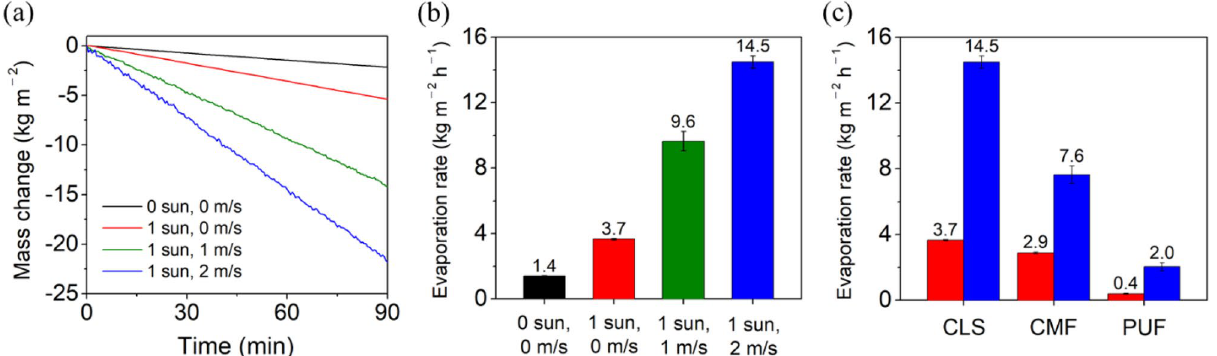
Figure 5. ( a ) Time-dependent changes in the mass of water under various conditions. ( b ) Evaporation rates of water with CLS under various conditions. The error bar represents the standard deviation obtained using three independent measurements. ( c ) Evaporation rates of water with CLS, CMF, and PUF under 1-sun illumination without wind (red) and with 2 m/s wind (blue).